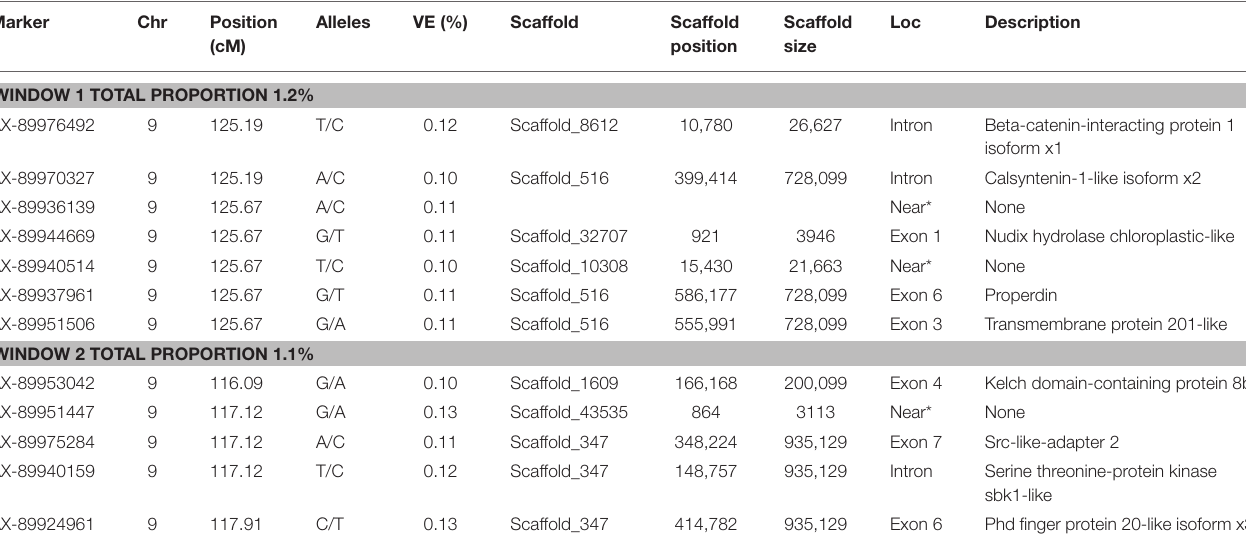
Loc Description size